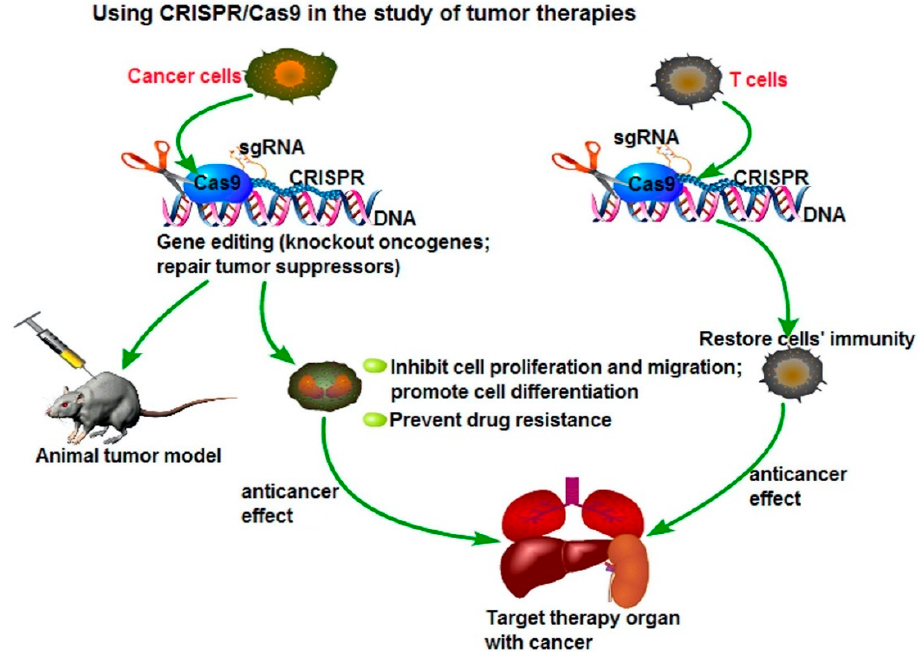
Figure 4. Using CRISPR/Cas9 in the study for tumor therapies. Reprinted with permission Figure [124], Clinical Genetics, 2019.